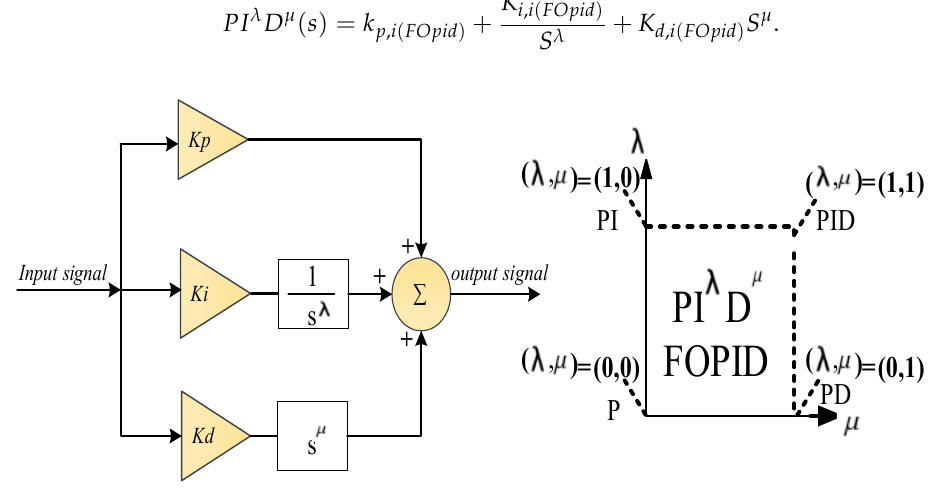
Figure 10. The structure of the FOPID controller.